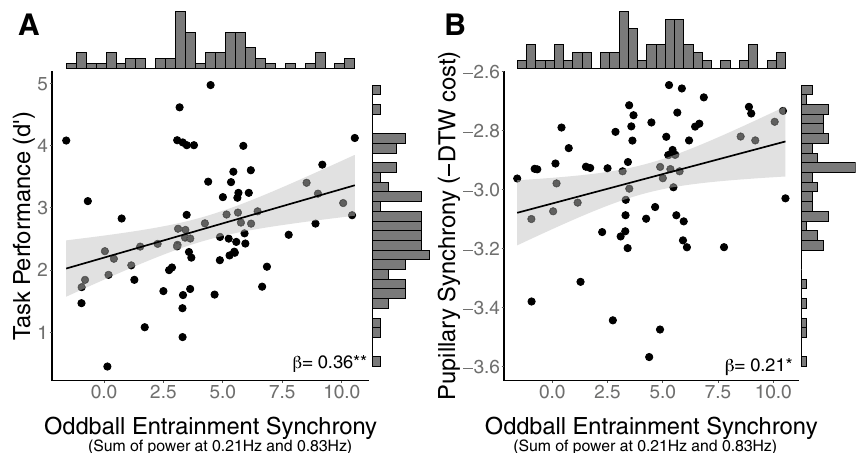
Figure 5. Data and estimated slopes for the relationship between ( A ) Oddball task performance and a sum of relative power at the inter-stimulus interval (ISI) and target stimulus interval (TSI). This relationship suggests that participants who performed the oddball task more accurately (as measured by d prime) were also more synchronized with the oddball task structure. ( B ) Relationship of pupillary synchrony between speakers and listeners with oddball entrainment synchrony. Entrainment synchrony was also positively related to pupillary synchrony such that the more synchronized participants were with the beat during the oddball task, the more synchronized their pupils were with the speaker in the listening